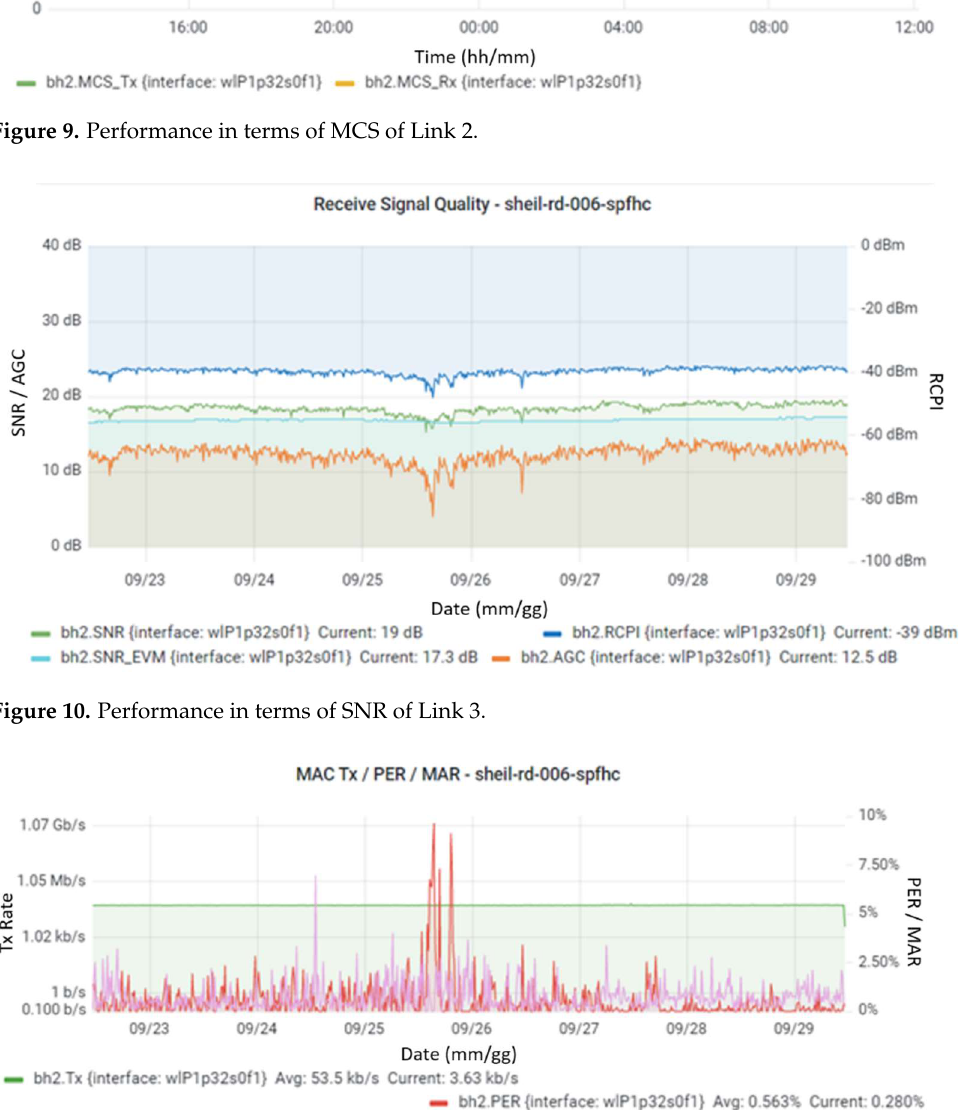
Figure 9. Performance in terms of MCS of Link 2.